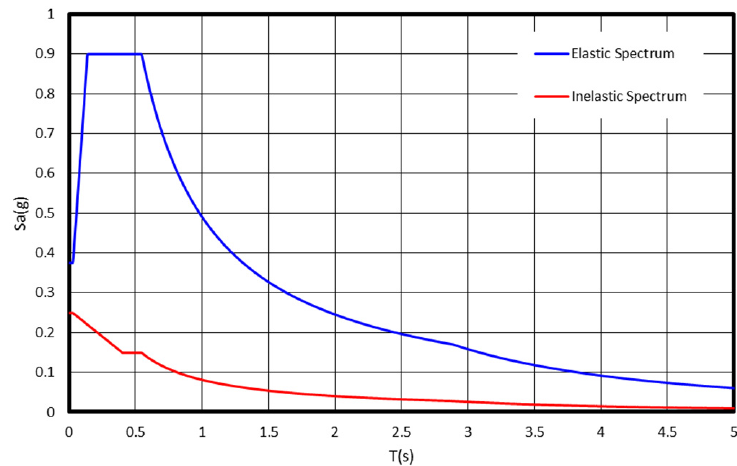
Figure 1. Response spectra according to COVENIN 1756-1 (2019).